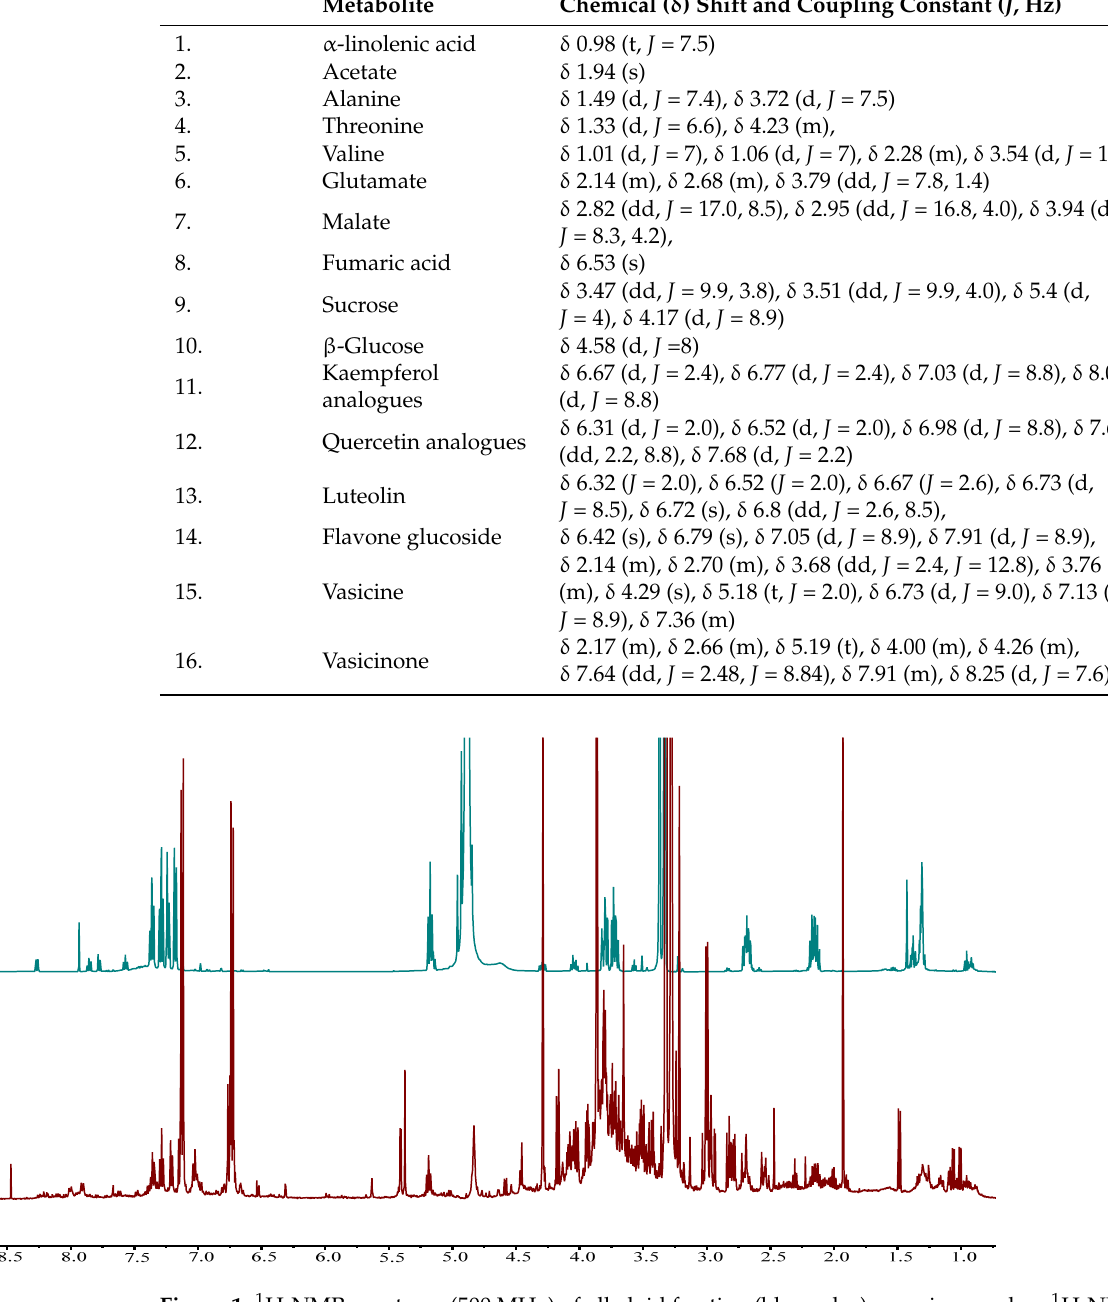
Table 2. 1 H chemical shifts (  ) and coupling constants (Hz) of metabolite of Vasaka leaves obtained